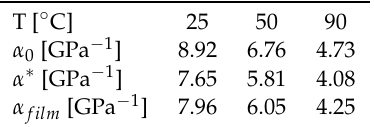
Figure 4. Viscosity pressure curves for two Isomers of Dodecane @ 40 ◦ C. Table 3. Pressure-viscosity coefficients for [Choline] [Proline].